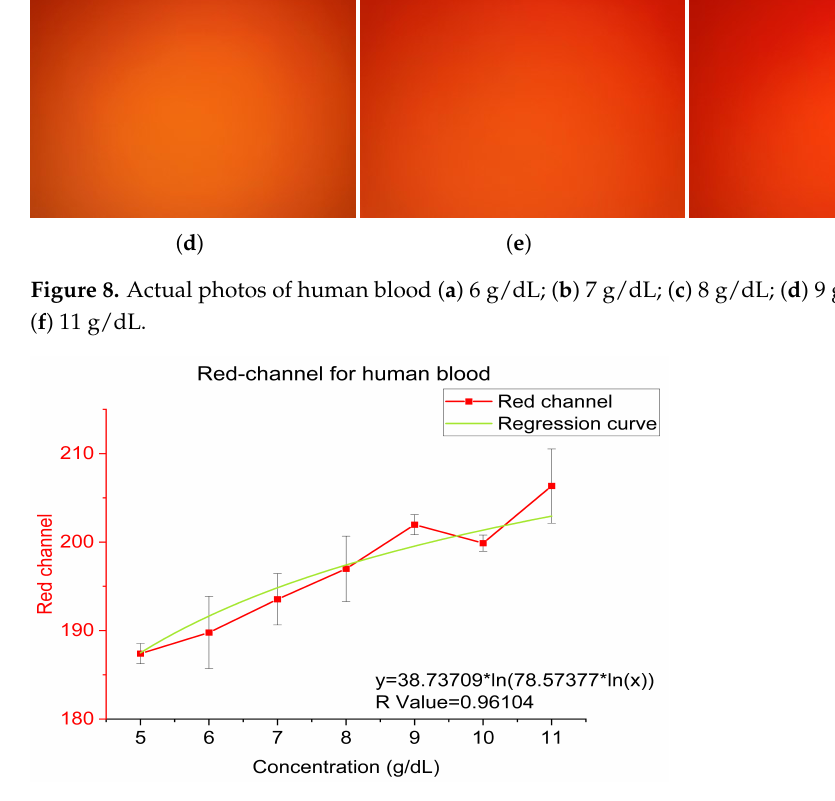
Figure 9. Red-channel value and regression for human